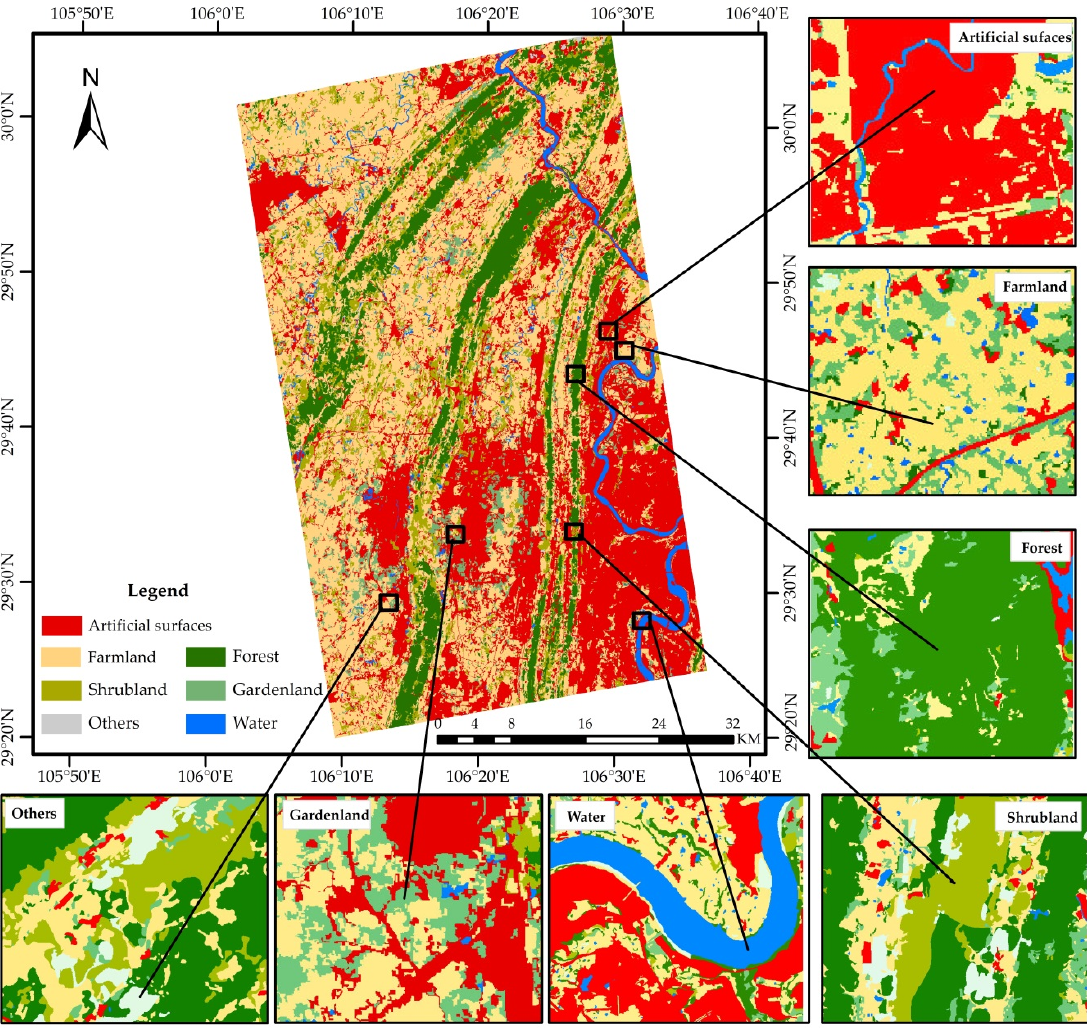
Figure 13. Classification results of fusion features.